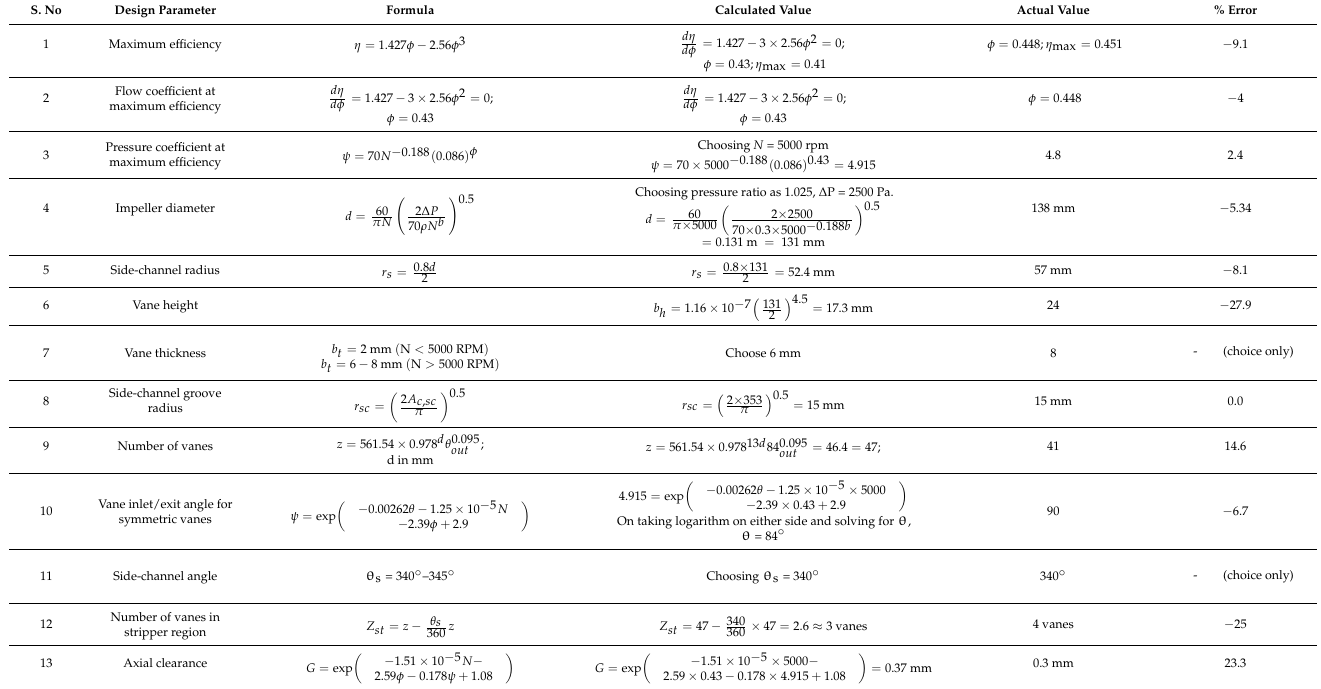
Table A1. Design of a blower having single-side vane impeller (data of Badami and Mura [1], 5000 rpm